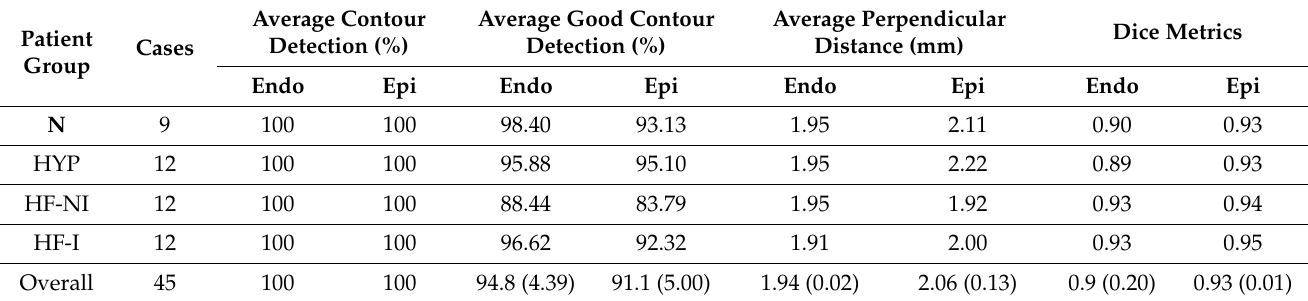
Table 12. Performance evaluation parameters for Tversky loss and Relu activation.